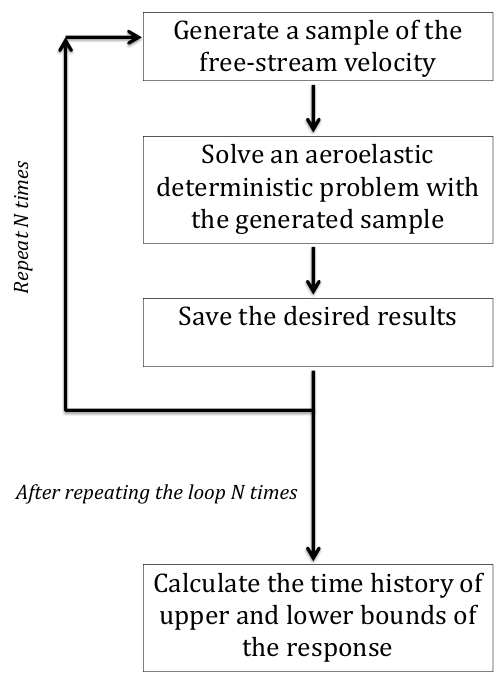
Figure 1. Monte Carlo simulation